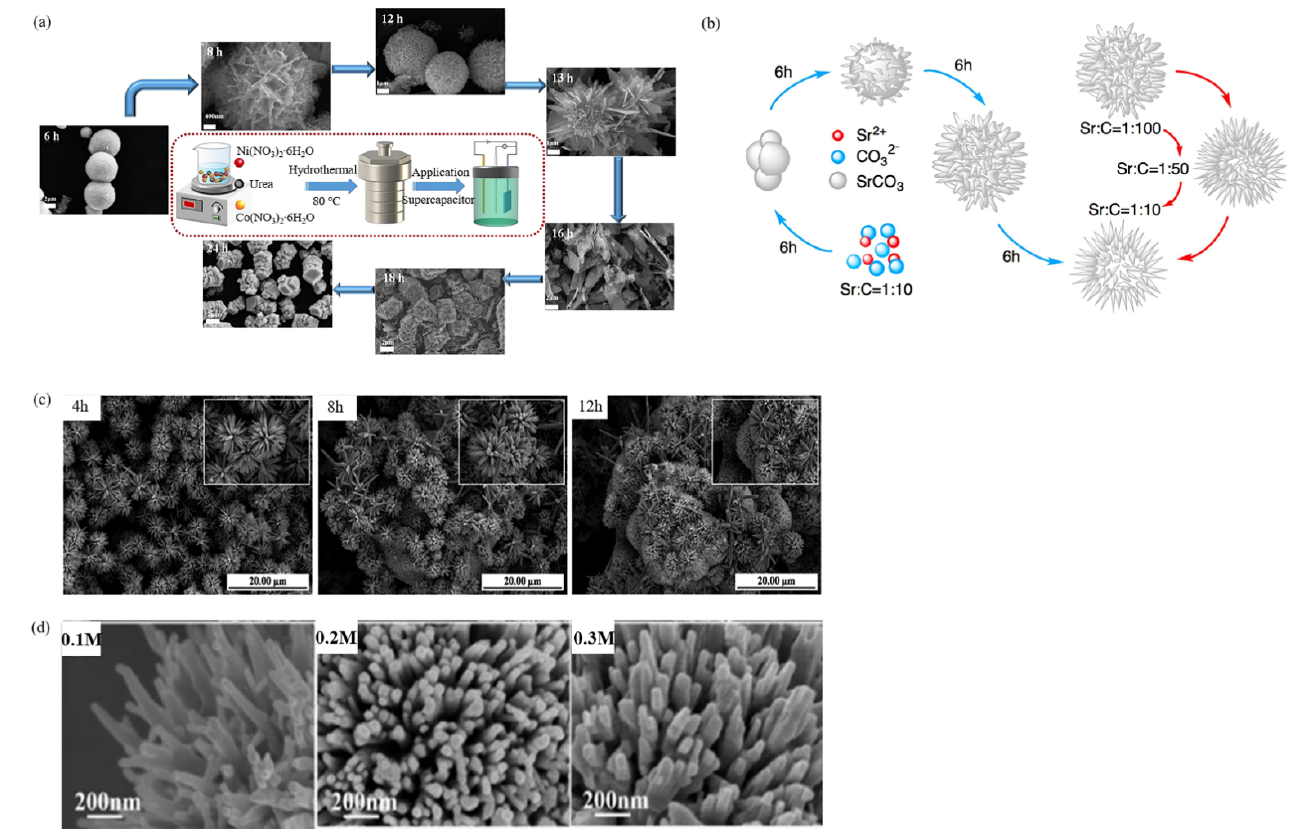
Figure 3. Effects of the reaction time and concentration of reactants on the morphology of urchin-like micro-/nanoparticles: ( a ) Preparation process of NiCo 2 O 4 with different morphologies under different reaction times [47] (Reprinted with permission from ref. [47]. Copyright 2021 John Wiley & Sons Ltd.). ( b ) A schematic illustration of SrCO 3 morphology evolution influenced by reaction time is in the left circle, that influenced by reactant concentrations is on the right [48] (Reprinted with permission from ref. [48]. Copyright 2017 Elsevier). ( c ) FESEM images of ZnO nanostructures prepared under different hydrothermal times [49] (Reprinted with permission from ref. [49]. Copyright 2016 Elsevier Ltd. and Techna Group S.r.l). ( d ) SEM images of products synthesized at different concentrations of the reaction solution [50] (Reprinted with permission from ref. [50]. Copyright 2019 World Scientific).